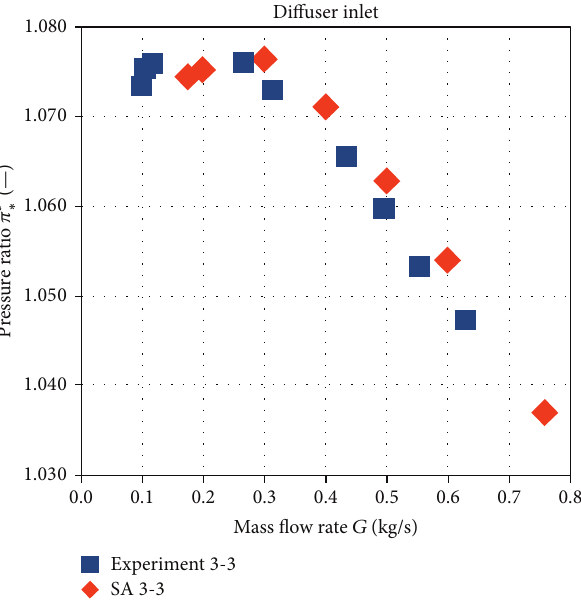
Figure 7: Pressure characteristic at the diffuser inlet for the Spalart- Allmaras turbulence model using second-order central discretiza- tion.